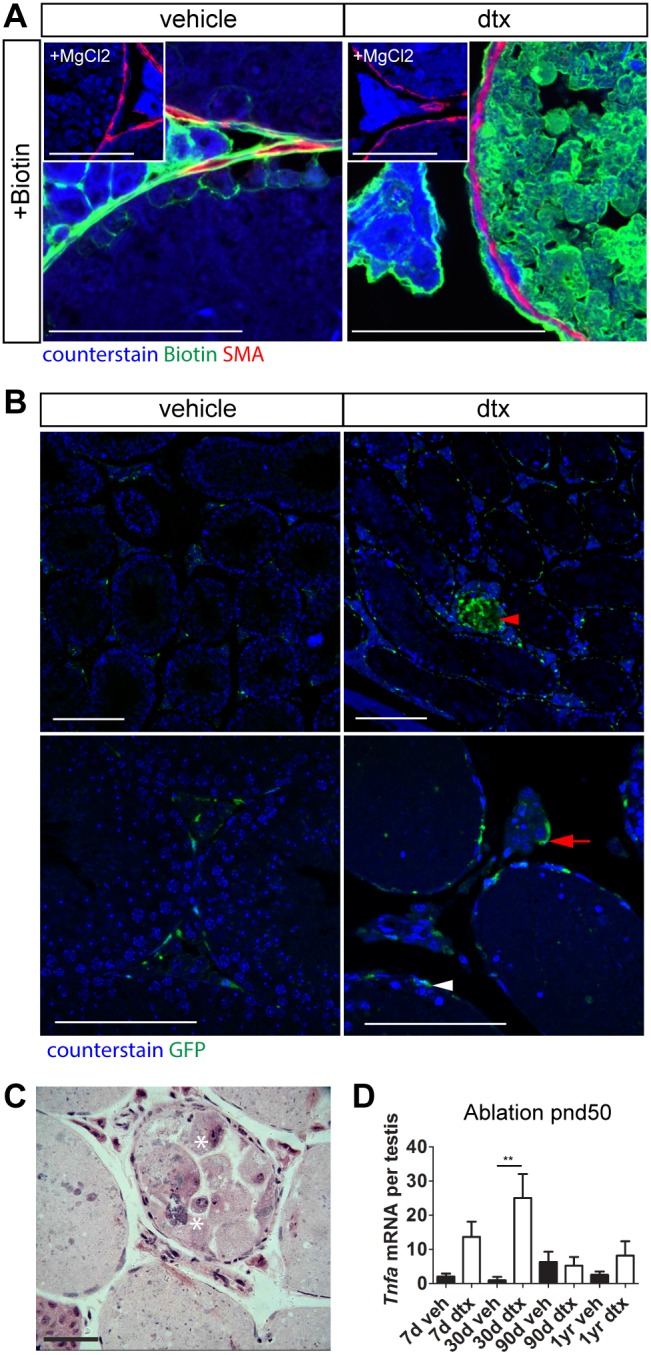
The PTMC/basement membrane inhibits immune cell infiltration of seminiferous tubules.(A) Biotin is prevented from entering the adluminal compartment by the Blood-Testis-Barrier in control animals. Conversely, 30 days post Sertoli cell ablation at pnd50, and despite the continued presence of the PTMC layer, biotin penetrates throughout the intratubular space. MgCl2: vehicle control. (B) Immunolocalization of macrophages (GFP) at 30 days following ablation at pnd50 using Amh-Cre+/+;iDTR+/+;CSFR-GFP mice (GFP antibody) shows that very few tubules are infiltrated by macrophages (red arrowhead). Macrophages are mainly present in the interstitium (arrow) or surrounding tubules (white arrowhead). (C) Sections from resinembeded testis highlighting the rare intra-tubular macrophage infiltration (asterisks). (D) Relative expression of the inflammatory cytokine Tnfa at key ages following Sertoli cell ablation at pnd50 (one-way ANOVA n = 5–9, **P<0.01) (scale bar: 100 µm). d,days; yr,year; dtx, injected with toxin; veh: vehicle control.